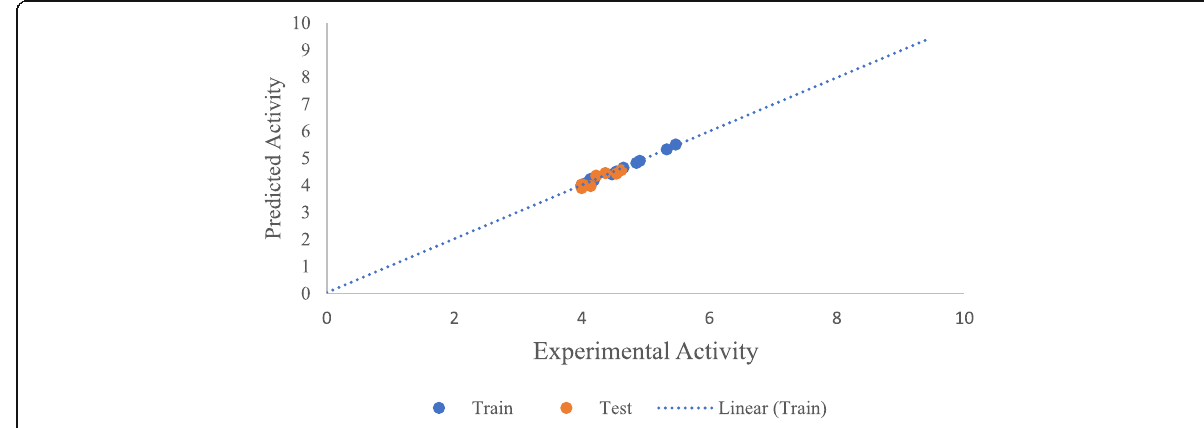
Fig. 2 Predicted activity vs experimental activity for both training set and test set